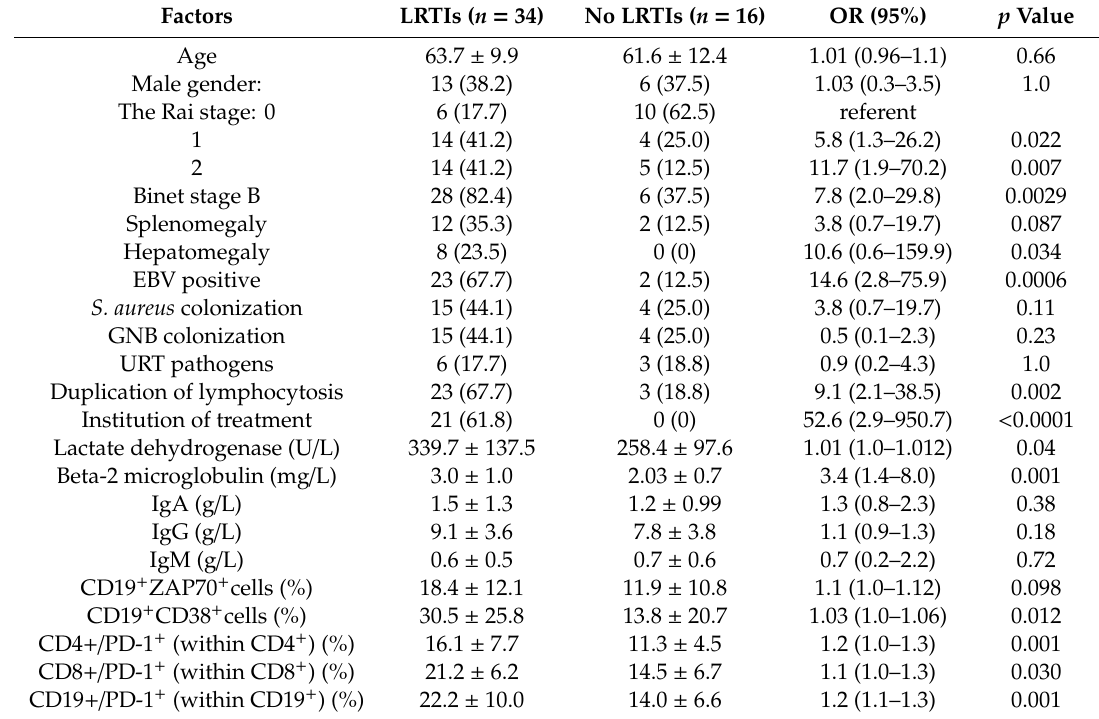
Table 3. Univariate analysis of risk factors for lower respiratory tract infections (LRTIs) in CLL